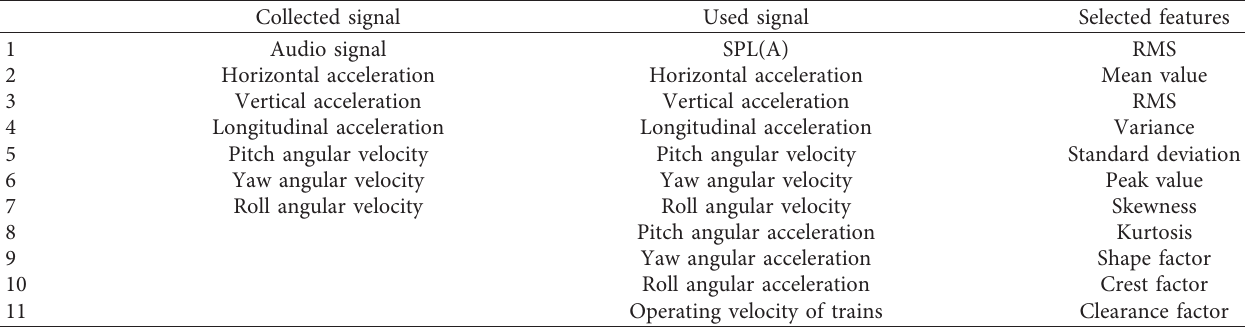
Table 2: Features involved in the prediction